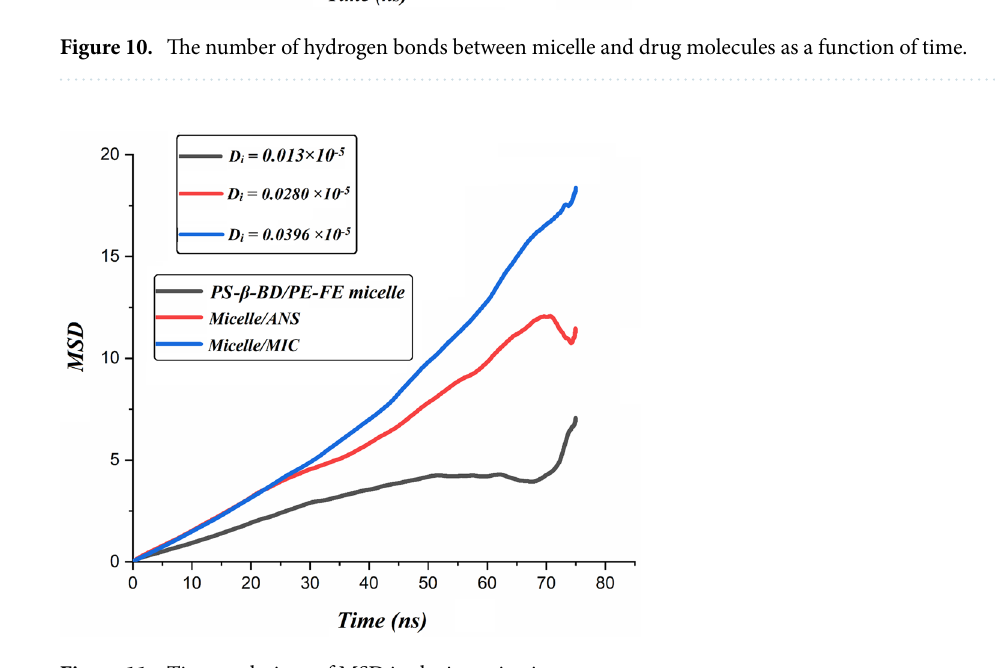
Figure 11. Time evolutions of MSD in the investigation